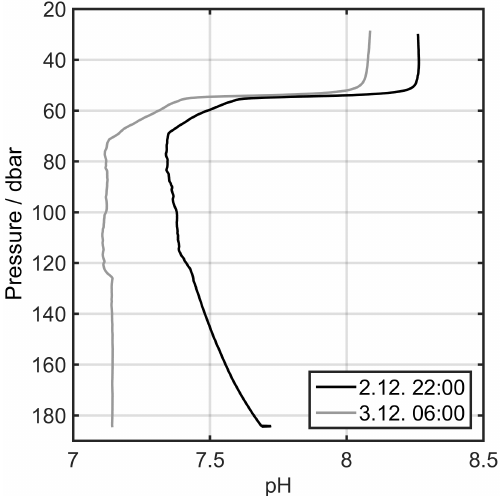
Figure 10. Battery voltage over the time of the third deployment from November 2010 to January 2011. The voltage usually drops during profiling and recovers during the 8h sleep period. At 3 De- cember and 9 January seemingly sudden drops in battery voltage occurred.